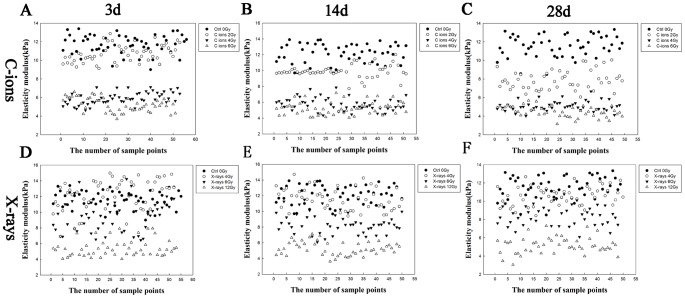
Variations of elasticity modulus for different doses of radiation in erythrocyte samples–control erythrocytes, and after suffering from the irradiation dose, the distribution effect of elasticity modulus was showed by scatters dots(A–F).